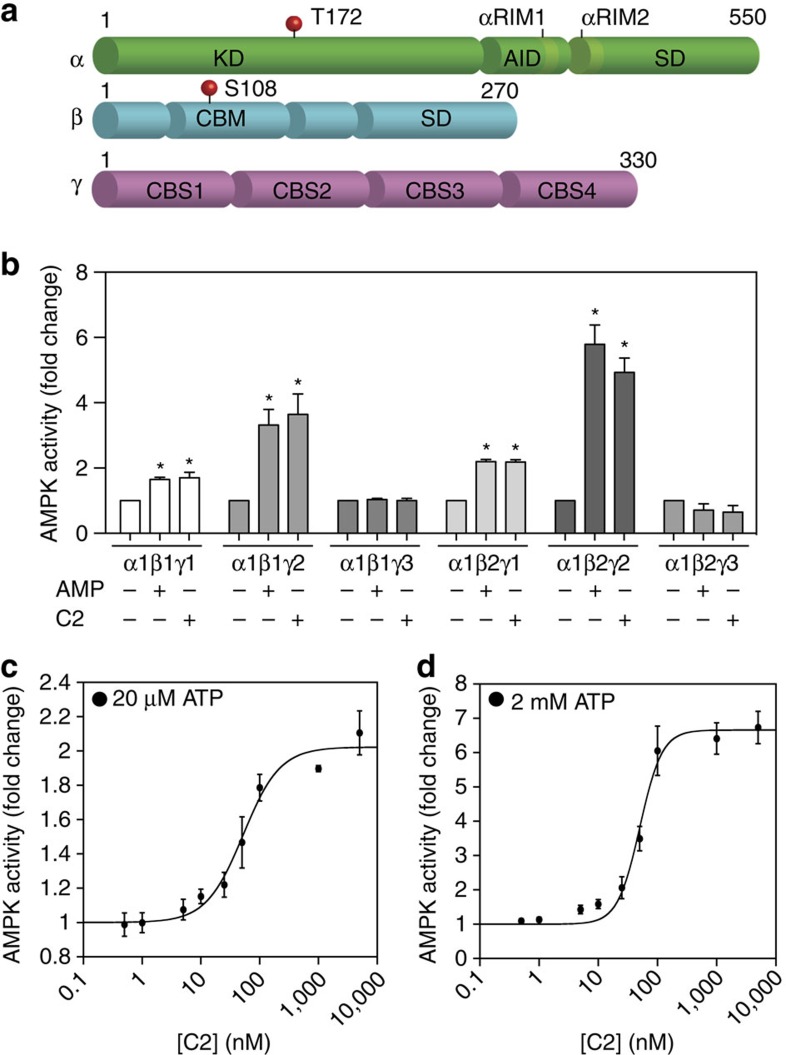
Allosteric activation of AMPK by C2.(a) Schematic representation of the three AMPK subunits: the catalytic α-subunit, and the regulatory β and γ-subunits. (b) C2 activation of AMPK α1 complexes. Activities of COS7 cell-expressed AMPK (complexes as indicated) were assayed in the absence or presence of C2 (0.1 μM) or AMP (100 μM). Results from triplicate experiments are presented as mean AMPK activity (fold change relative to basal±s.e.m.), with statistical tests conducted using one-way ANOVA. *P<0.05 indicates significant increase in activity compared to untreated control. Effect of ATP concentration on C2 activation of AMPK α1. C2 dose–response (0–5 μM) at (c) low (20 μM) ATP and (d) near-physiological (2 mM) ATP. Results from six independent experiments are plotted as AMPK activity (fold change±s.e.m.) versus [C2] (nM). The values for EC50, fold stimulation and Hill coefficients were calculated based on fitting the data to the equation: Activity=Basal+(((Fold stimulation × Basal)−Basal × [C2]h)/ ((EC50)h+[C2]h)). AID, auto-inhibitory domain; CBM, carbohydrate-binding module; CBS, cystathionine β-synthase motif; KD, kinase domain; RIM, regulatory subunit-interacting motif; SD, scaffold domain.